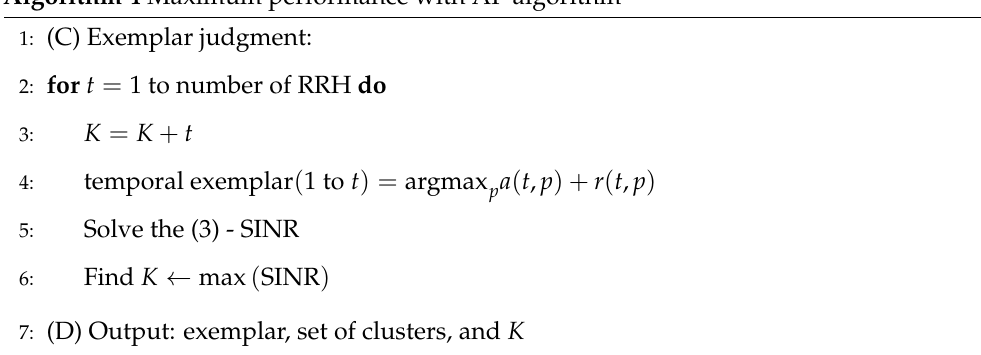
Algorithm 4 Maximum performance with AP